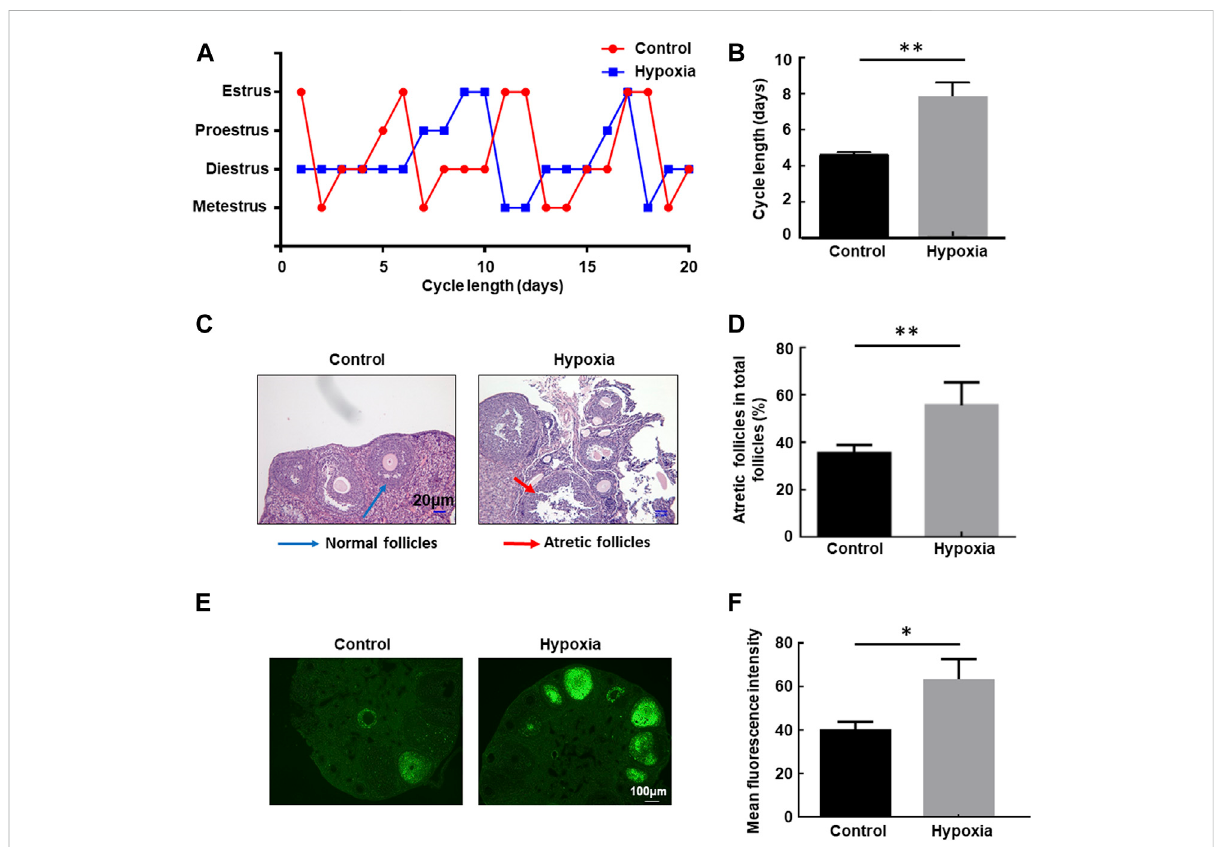
FIGURE 1 Hypobaric hypoxia-induced estrous cycle disorder and follicular atresia in female mice. (A – B) Eight-week-old unmated female mice were left untreated or exposed to hypobaric hypoxic conditions that simulated 6000-m altitude for 48 h, and then the estrous cycle of each group mice was examined in the following three weeks. The distribution of estrous cycles of representative untreated and hypoxia-treated mice is shown in (A) . The average estrous cycle length of mice from each group is shown in (B) ( n = 20, ** p < 0.01). (C – D) Female mice were raised under normoxic or hypobaric hypoxic conditions at ZT0. Mice were euthanized after 48 h, and the ovaries were collected and subjected to HE staining. Follicle categorization was performed, and the percentage of atretic follicles of the total follicles was calculated. ( n = 6, ** p < 0.01). (E) TUNEL assay